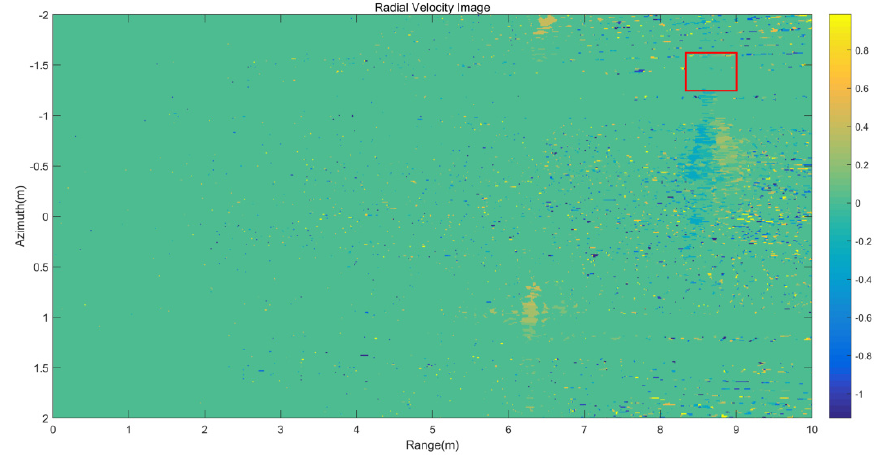
Figure 11. Kelvin wake radial velocity image.